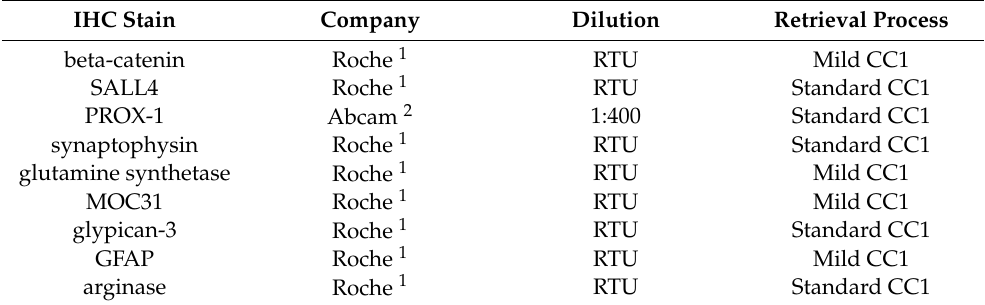
Table 1. Immunohistochemical Stain Information. IHC Stain